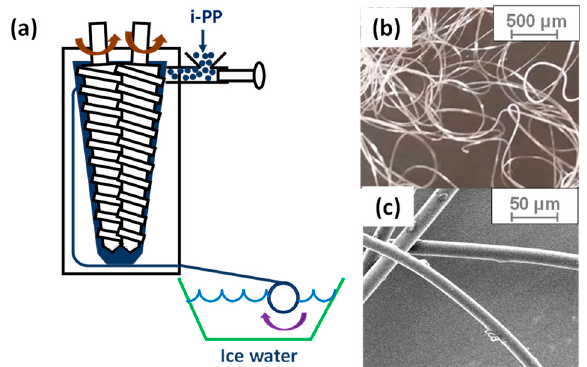
Figure 2. ( a ) Schematics of a fiber spinning system to fabricate heat-activated shrinking (HAS) microfibers. The heat-passive (HP) microfibers were fabricated without icy water and were cooled at room temperature while they are continuously collected. ( b , c ) Microfibers fabricated by fiber spinning.